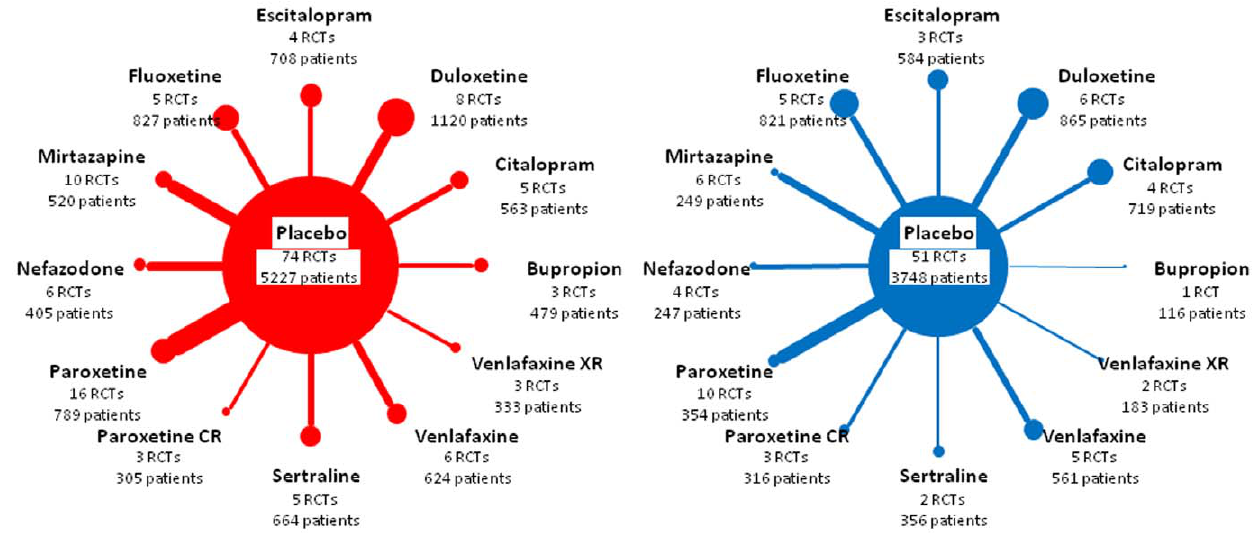
Figure 1. Star-shaped networks of comparisons of data from 74 US Food and Drug Administration (FDA)-registered trials of 12 antidepressants and their 51 related publications. The central node represents the placebo, and each leaf node represents an antidepressant agent. Each node diameter is proportional to the number of patients who received the antidepressant agent; each connecting line width is proportional to the number of trials that addressed the comparison.